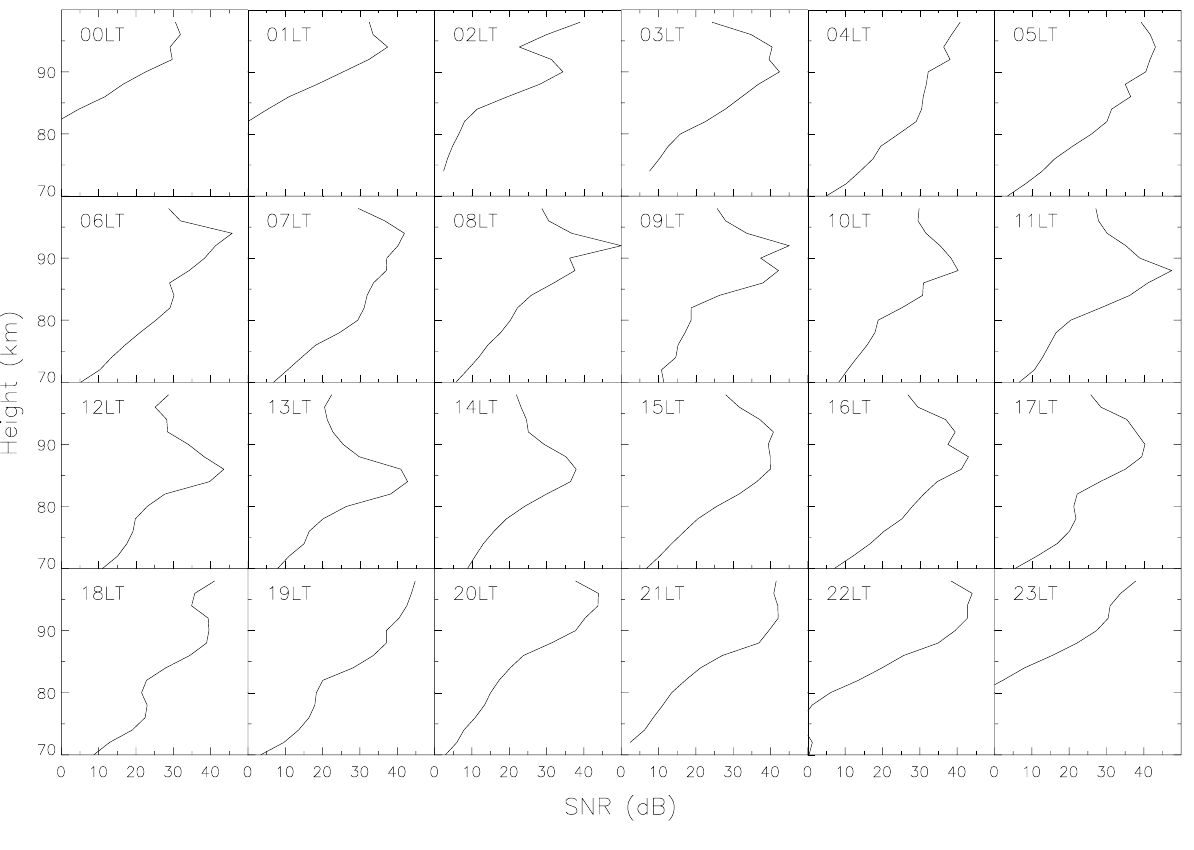
Fig. 1. The hourly averaged SNR profiles for 24 December